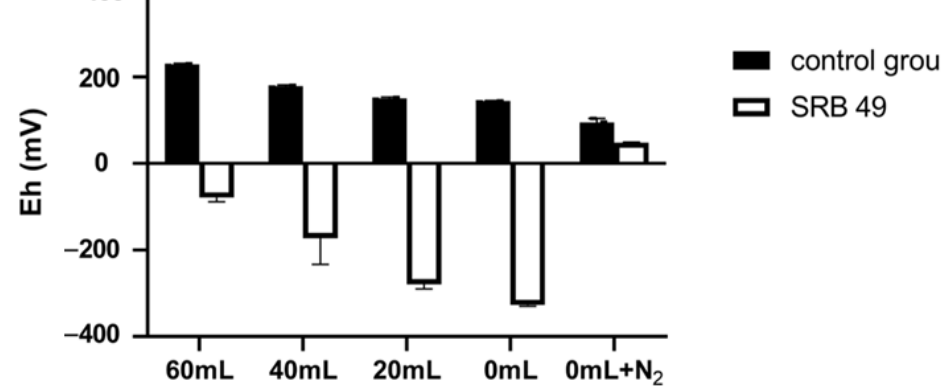
Figure 4. The redox potential in the synthetic wastewater with different upper air after incubated with and without SRB49 for 48 h.